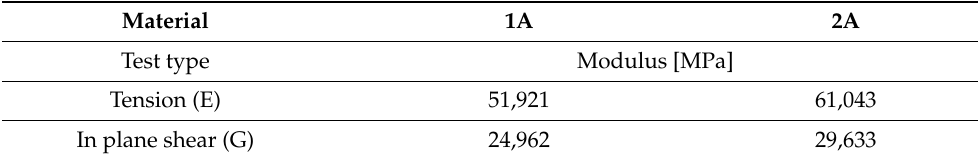
Table 1. The values of elastic constants obtained for 1A and 2A specimens.